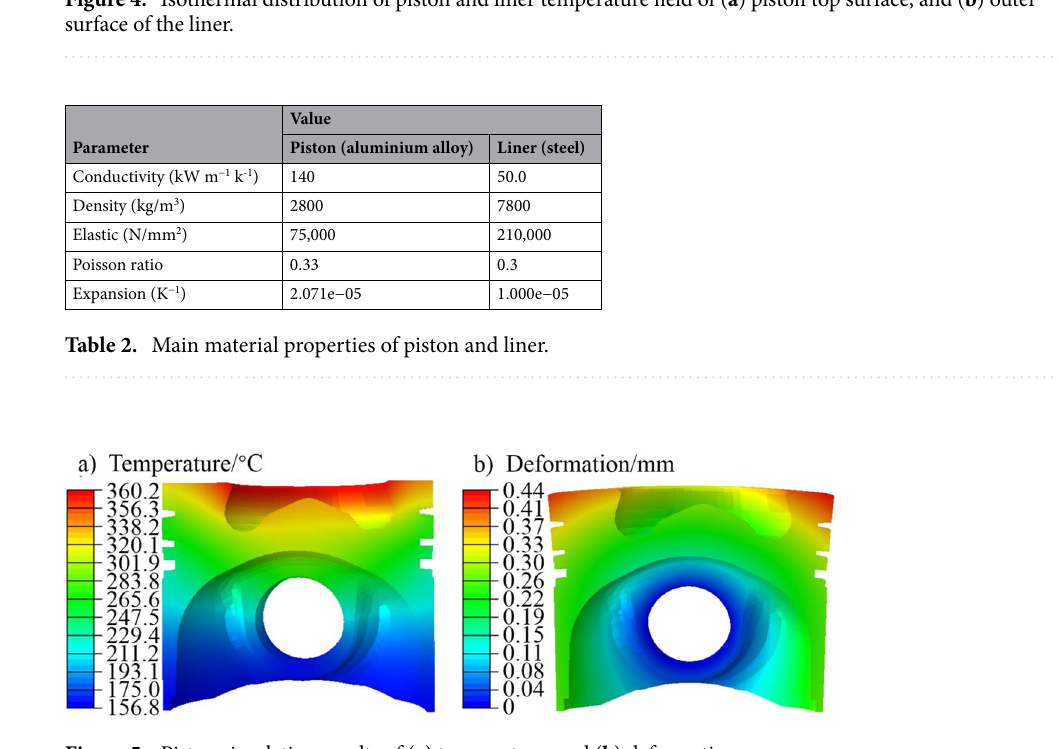
Figure 5. Piston simulation results of ( a ) temperature, and ( b )